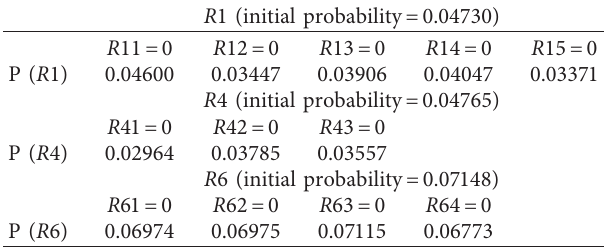
Table 11: Risk reassessment results of R 1, R 4, and R 6.